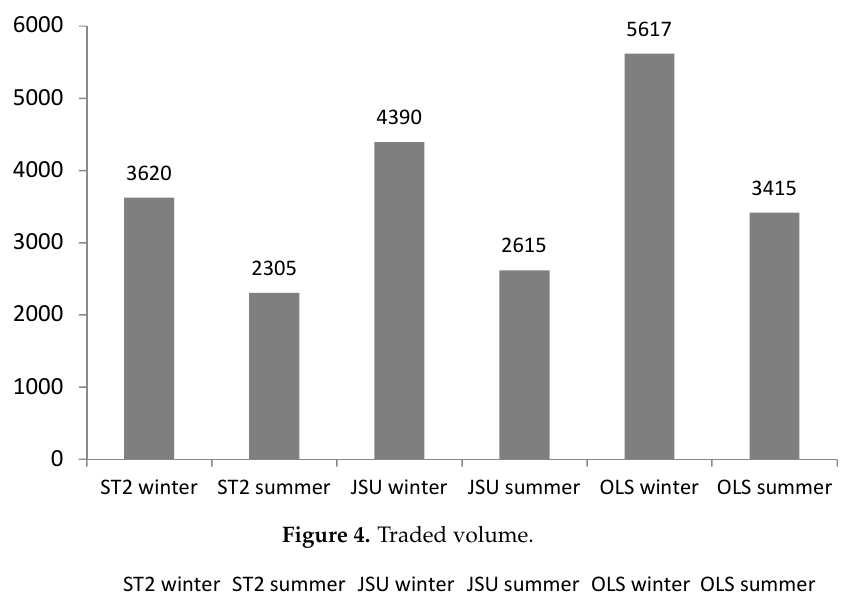
Figure 4. Traded volume.